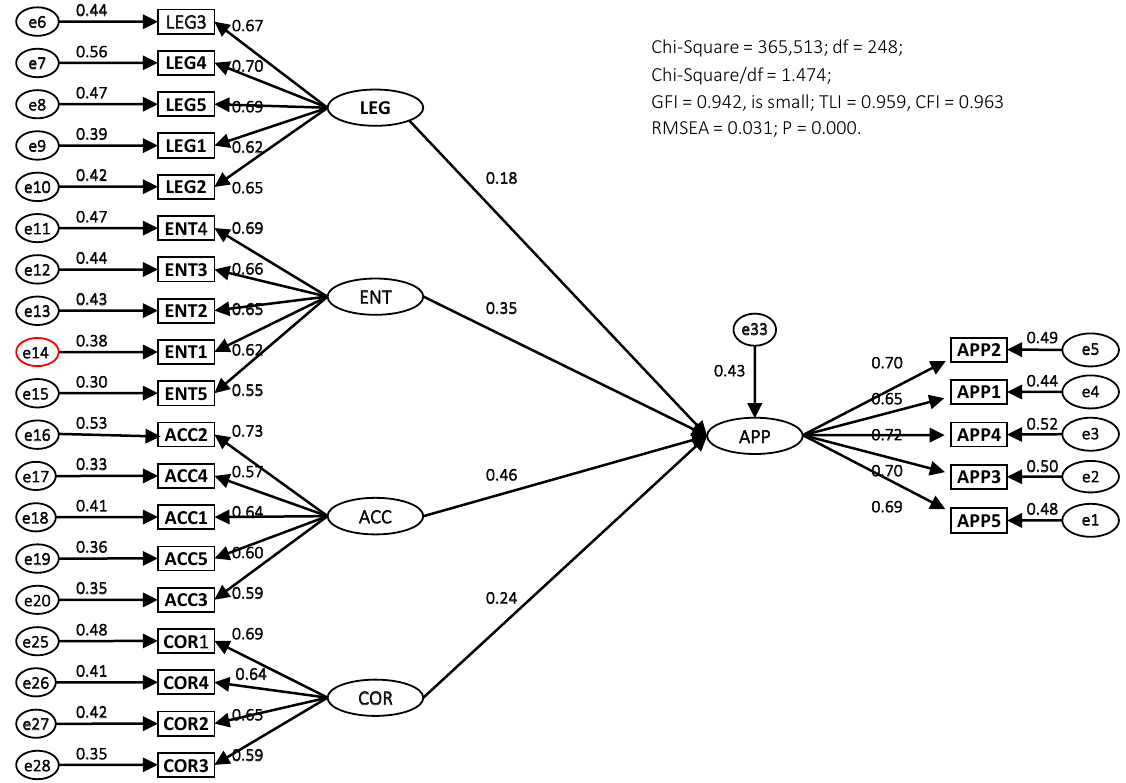
Figure 3. SEM results of the official research model (standardized)